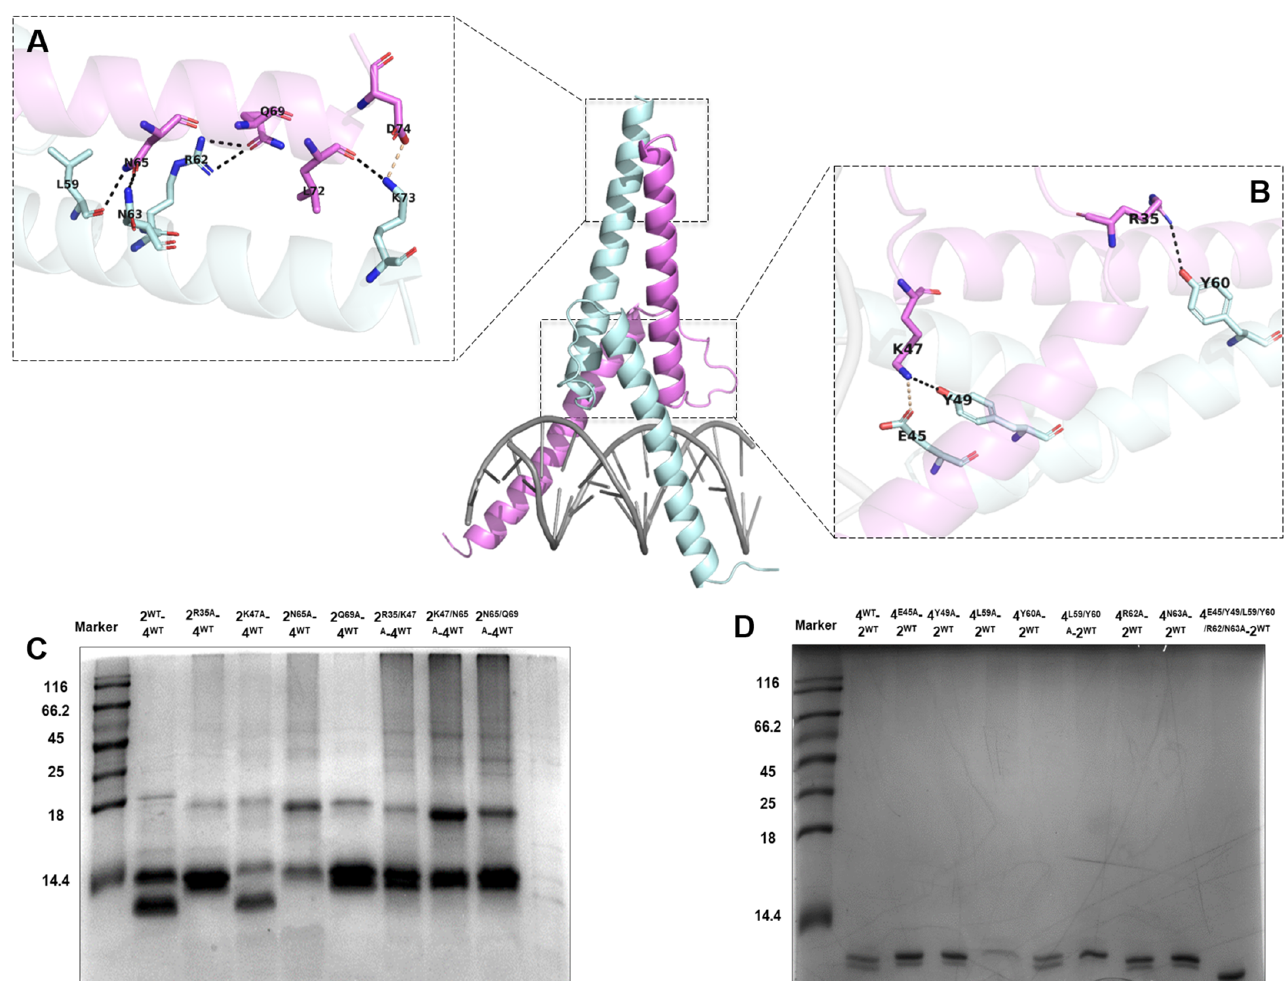
Figure 6. Mutual interaction of Ino2p DBD and Ino4p DBD : ( A , B ) Magnified view of the interacting residues from both Ino2p DBD and Ino4p DBD proteins; In vitro binding profiles of ( C ) Ino2p DBD and ( D ) Ino4p DBD for protein–protein mutual interactions. These analyses revealed several critical residues (Arg35, Asn65, and Gln69 of Ino2p DBD and Leu59 of Ino4p DBD ) for establishing the interprotein interaction. Triplicate samples were used in parallel to validate the critical residues for protein–protein interaction.